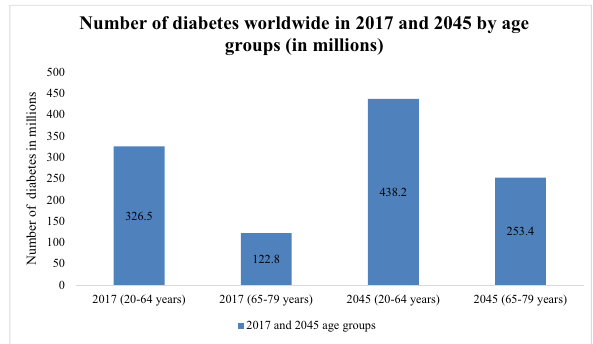
Figure 1: Worldwide prevalence and prediction of diabetes in 2017 and 2045 [ 15 ]